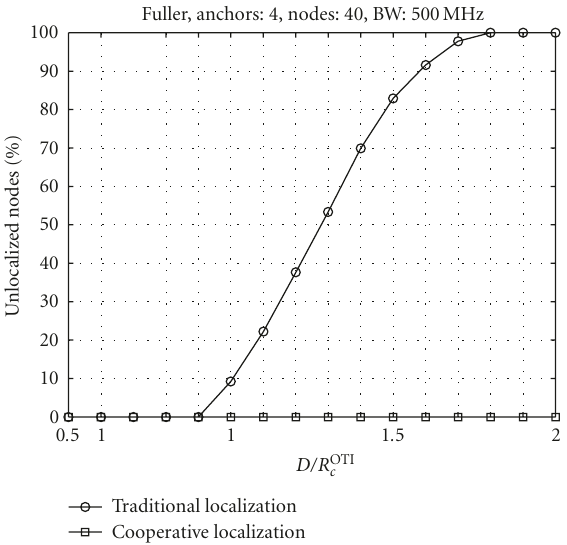
Figure 3: Percentage of unlocalized sensor nodes as a function of . D/R OTI c